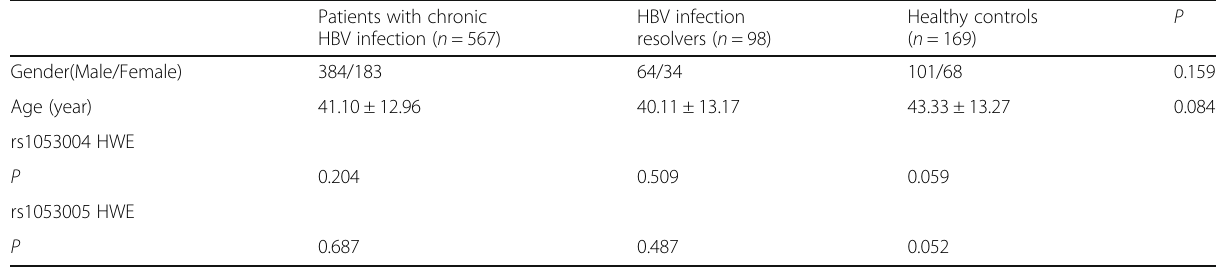
Table 1 Demographics and Hardy-Weinberg equilibrium (HWE) of the genotypes of STAT3 rs1053004 and rs1053005 in patients with chronic hepatitis B virus (HBV) infection, HBV infection resolvers and healthy controls Patients with chronic HBV infection HBV infection ( n = 567) resolvers ( n =